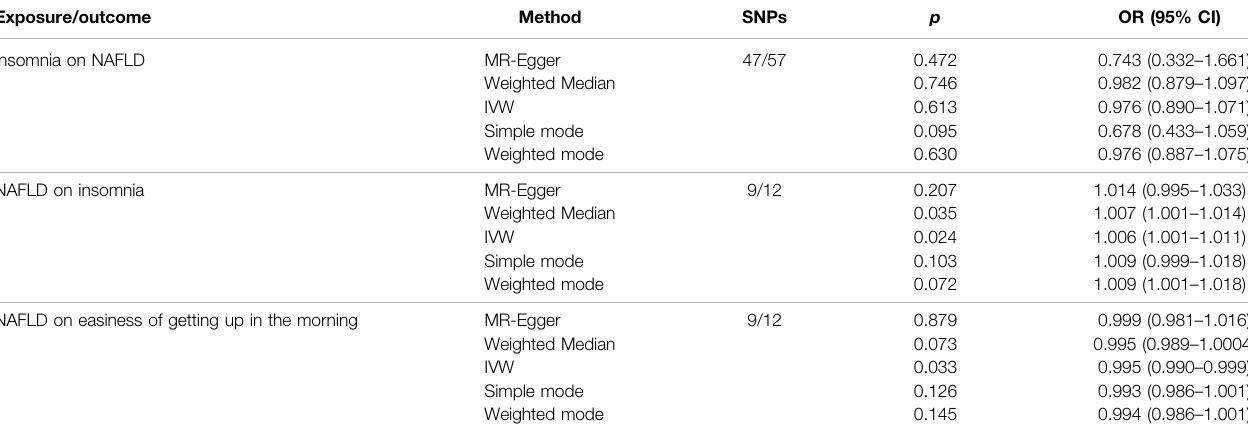
TABLE 3 | Association between genetically predicted insomnia on nonalcoholic fatty liver and genetically predicted nonalcoholic fatty liver on insomnia and easiness of getting up in the morning used as instrument variables.